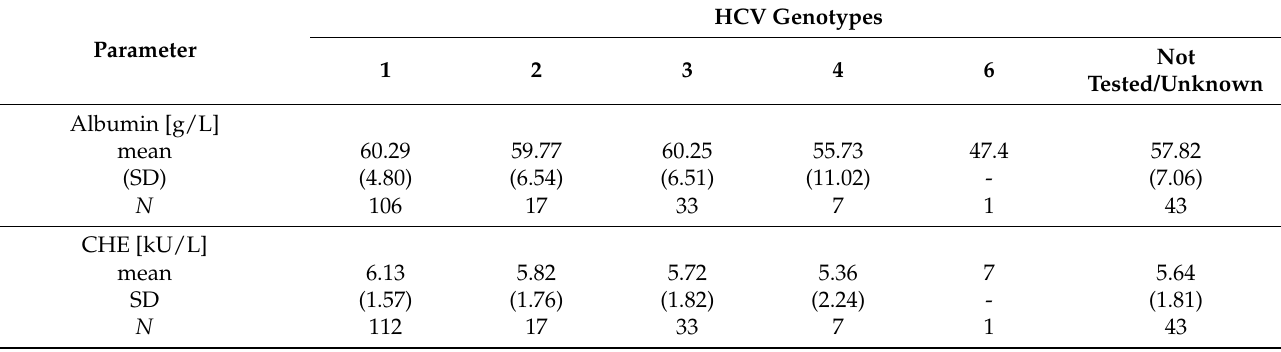
Table A2. Patient characteristics in different HCV